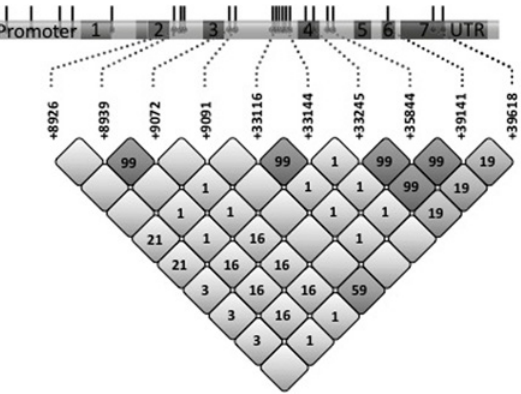
Fig 2. Distribution of polymorphisms and pair wise LD analysis (r 2 ) observed in COLEC11 . A schematic drawing of the gene COLEC11 is given at the top. Exons are numbered and promoter and non-translated regions are indicated. The numbers in the grid refer to the r 2 values of a given pair of SNPs. Darker colours of the boxes means higher r 2 values.